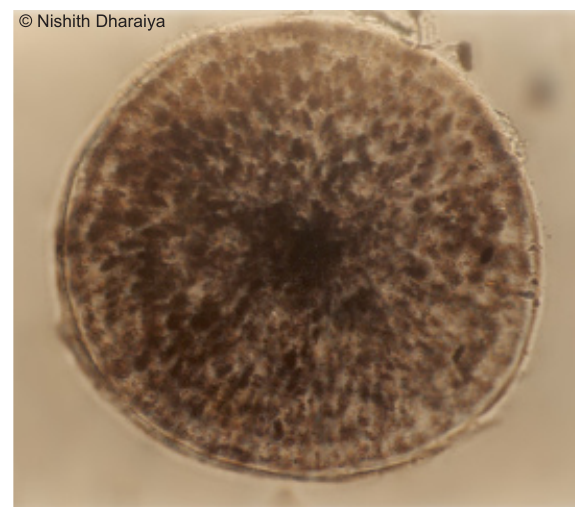
Image 4. Cross section of hair of Domestic Buffalo